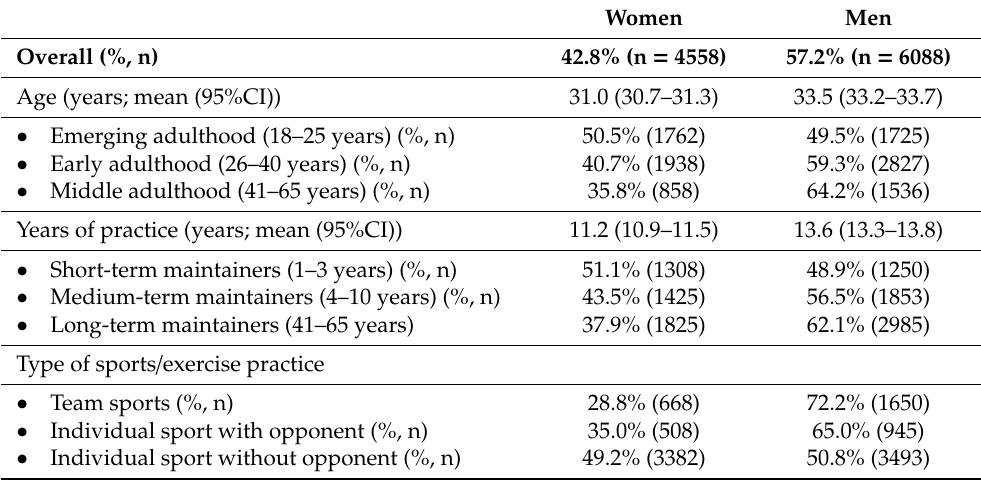
Table 1. Characteristics of study participants according to gender (women,